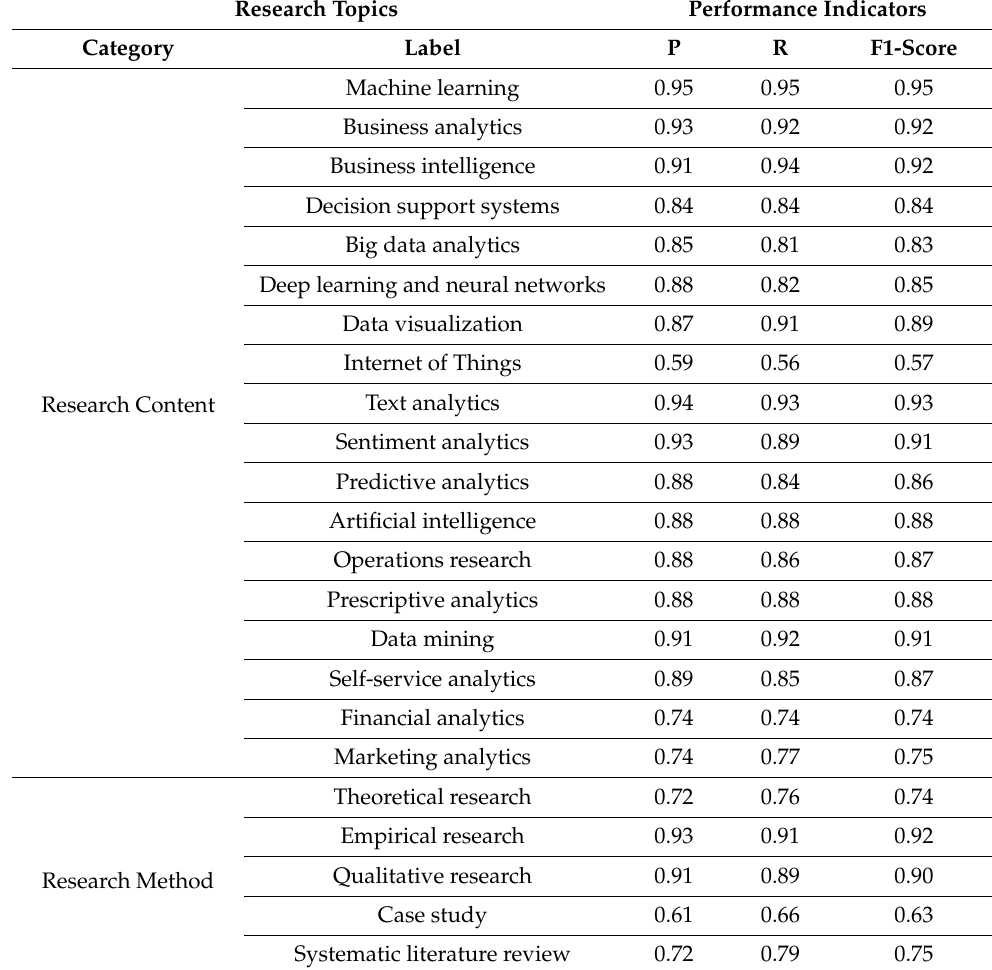
Table 7. Classification results of data science and analytics literature topic categories.